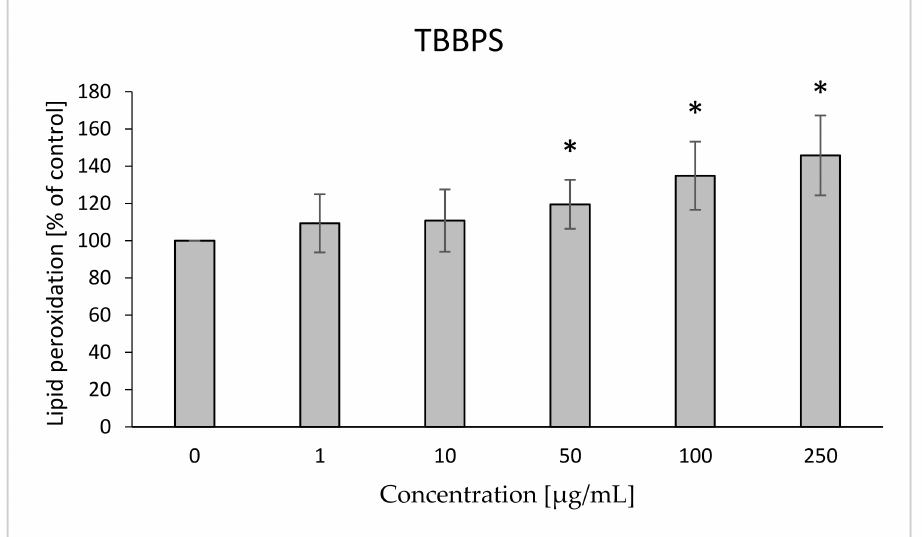
Figure 8. Lipid peroxidation in human control erythrocytes and the erythrocytes incubated with TBBPS at 1 to 250 µ g/mL for 48 h. (*) Significantly different from control ( p <